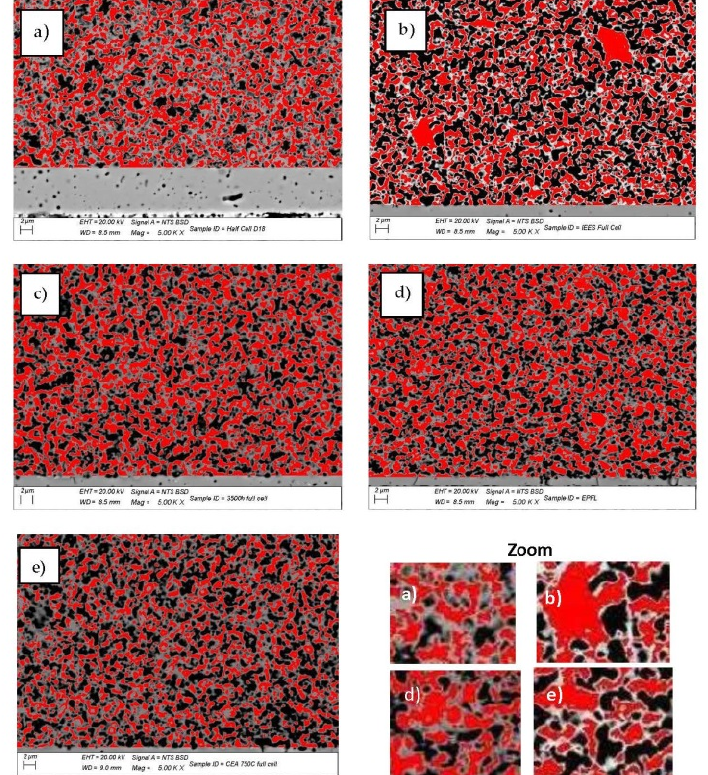
Figure 16. SEM-BSE images of: ( a ) sample A (pristine); ( b ) sample B (20 redox cycles); ( c ) sample C (3500 h); ( d ) sample D (3000 h); ( e ) sample E (1800 h in electrolyzer mode) (red—Ni; black—pores;